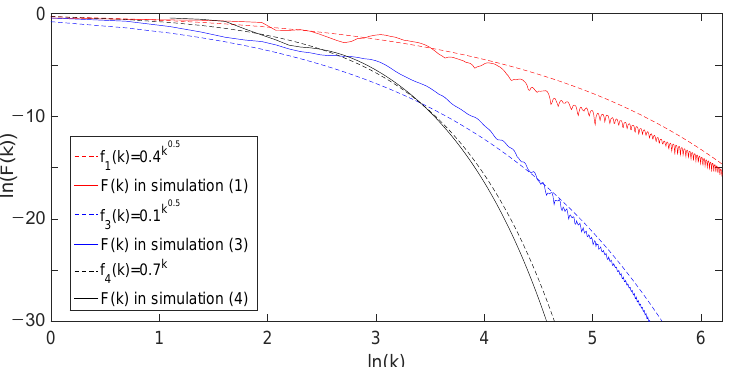
Figure 8. The system error curve in the simulation (1), the simulation (3) and the simulation (4) under logarithmic